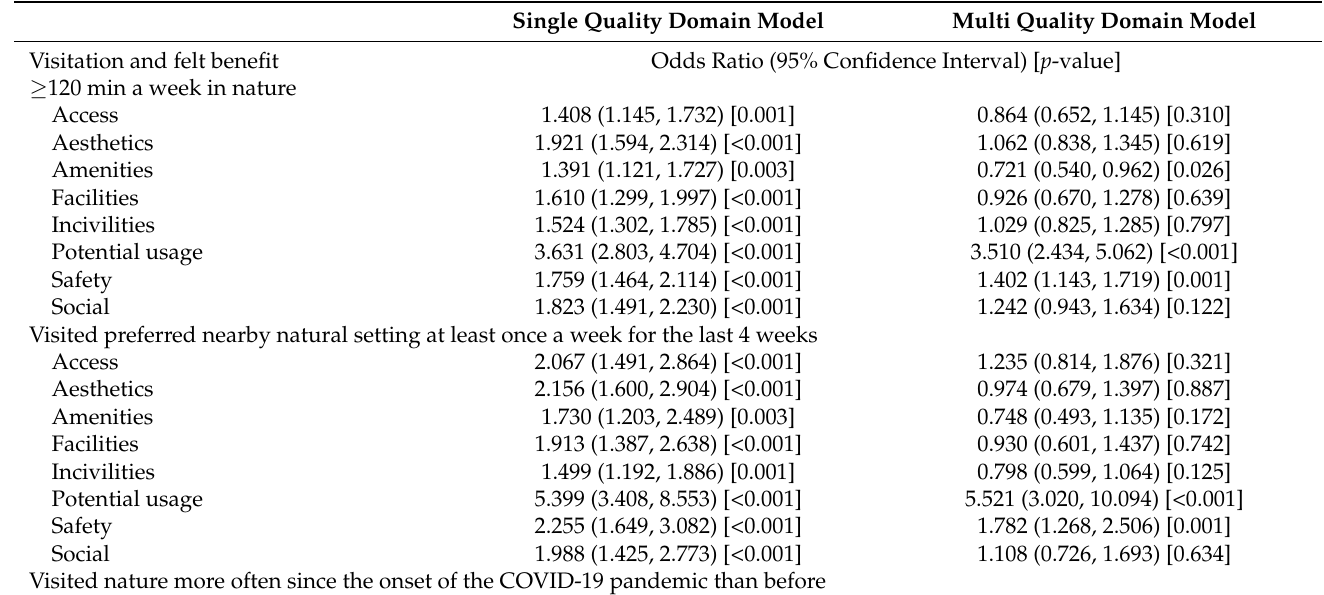
Table 5. Adjusted associations between qualities of nearby natural settings and visitation and felt benefits, weighted for national